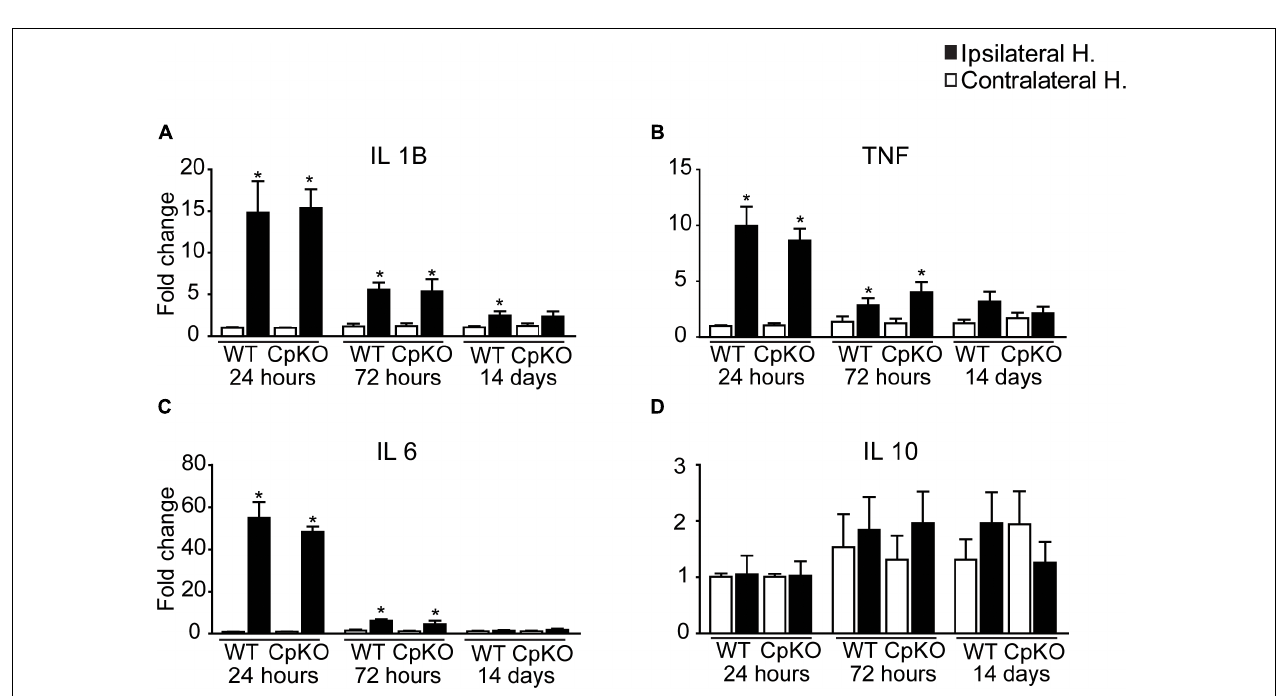
FIGURE 8 | Changes in protein oxidation detected by 3-nitrotyrosine labeling. Tissue sections of wildtype (A) and CpKO (B) mice showing immunohistochemical staining for 3-NT. The 3-NT staining is seen as a brown reaction product. (C) Graph shows that the number of 3-NT+ cells shows a trend to be higher in CpKO compared to wildtype mice but does not reach statistical significance. The tissue sections were counterstained with Mayer’s hemalum which labels the cell nuclei blue. n = 4; scale bar = 100 µ m.